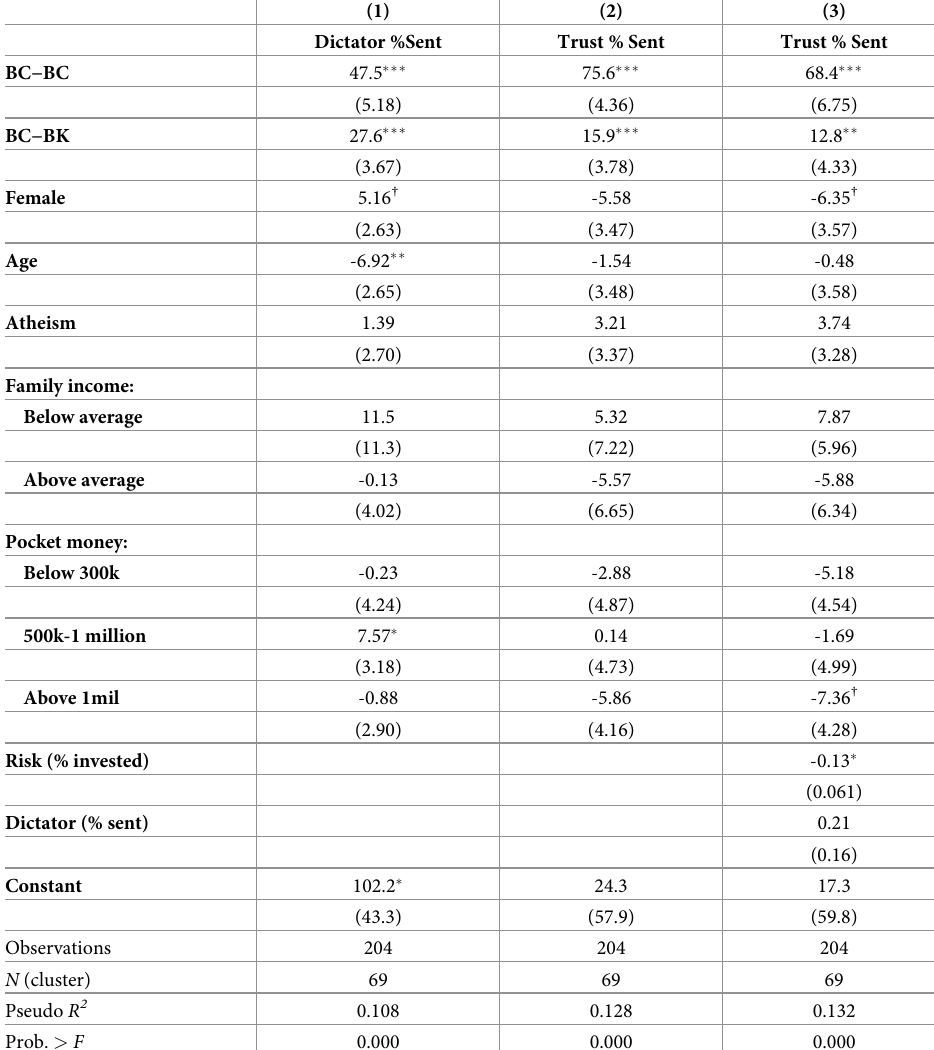
Table 6. Between-school